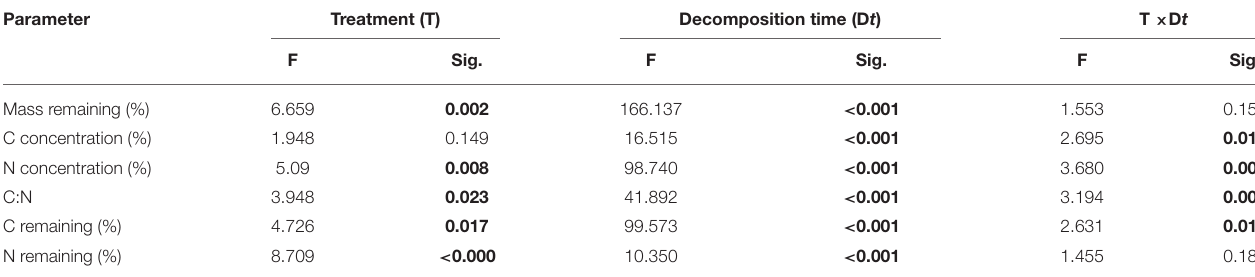
TABLE 1 | Results of the two-way ANOVA for the effect of treatment (T) and decomposition time (D t ) on the variation of fine root decomposition traits of Artemisia halodendron . Parameter Treatment